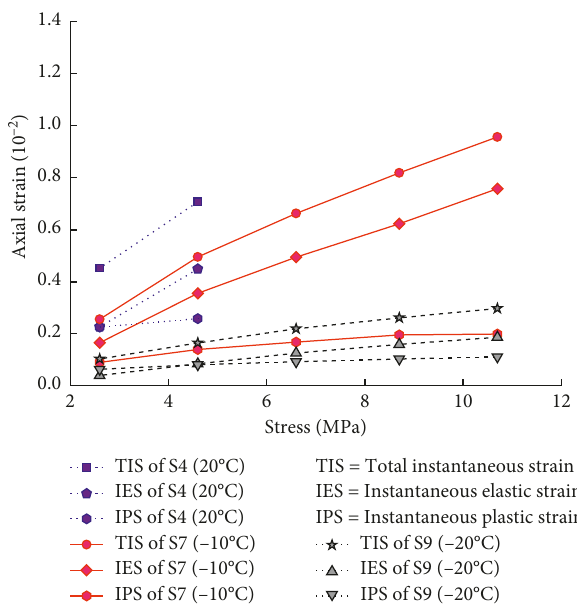
Figure 6: Instantaneous strain versus stress.